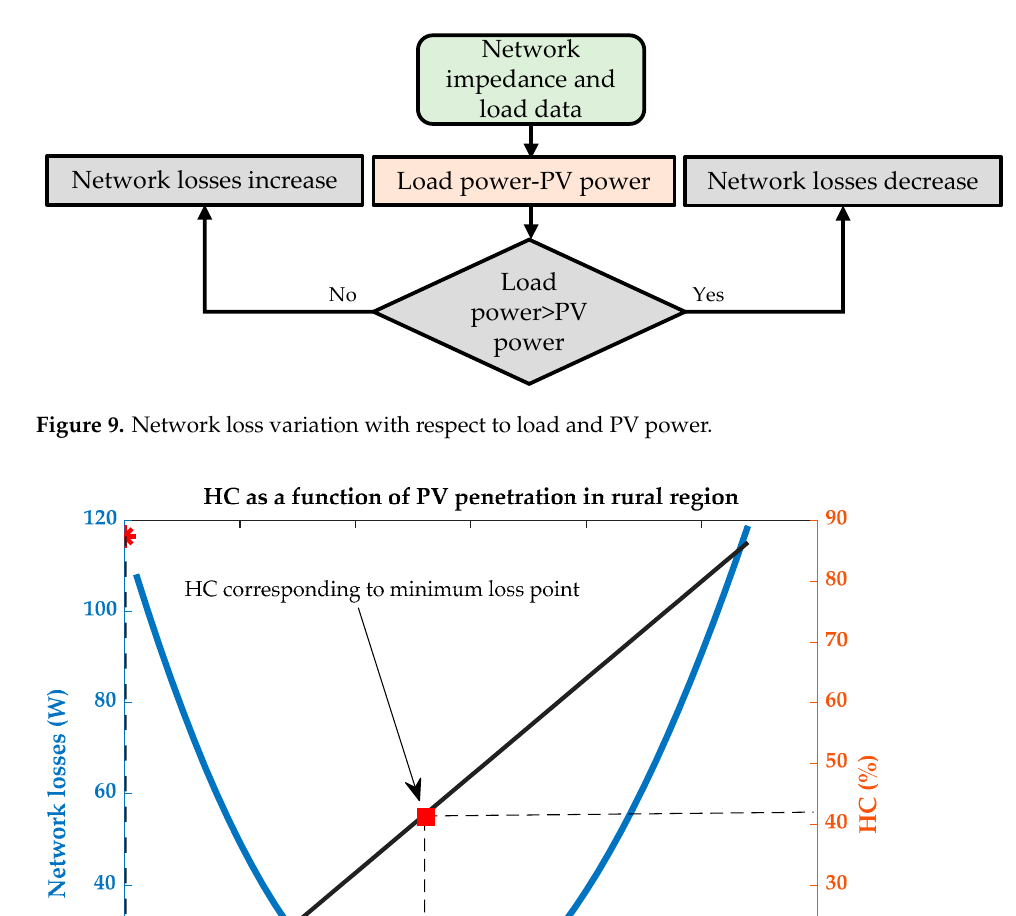
Table 9. PV penetration level at the minimum point of network losses for three regions for the balanced PV deployment scenario.